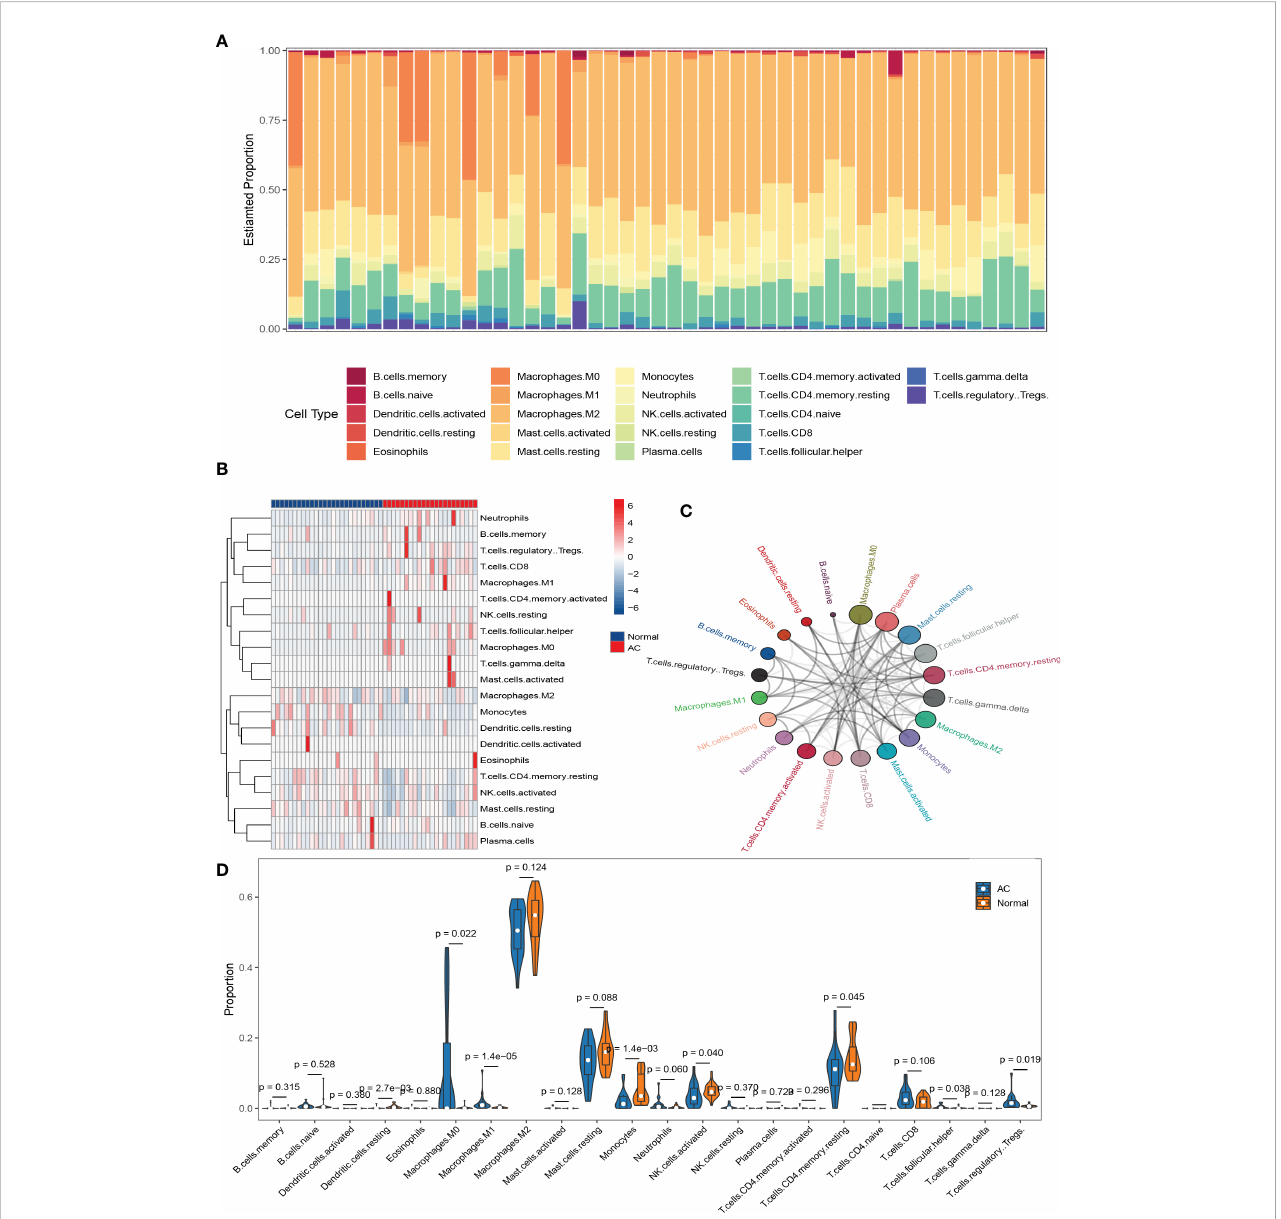
FIGURE 5 The results of immune cell in fi ltration analysis. Composition of 22 types of in fi ltrating immune cells in each sample was shown in a bar chart (A) and a heat map (B) . Network diagram of 22 types of in fi ltrating immune cells. Larger circles represent stronger interactions with other immune cells (C) . Wilcoxon test was used to identify signi fi cantly different in fi ltrating immune cells in AC and normal tissues (D)